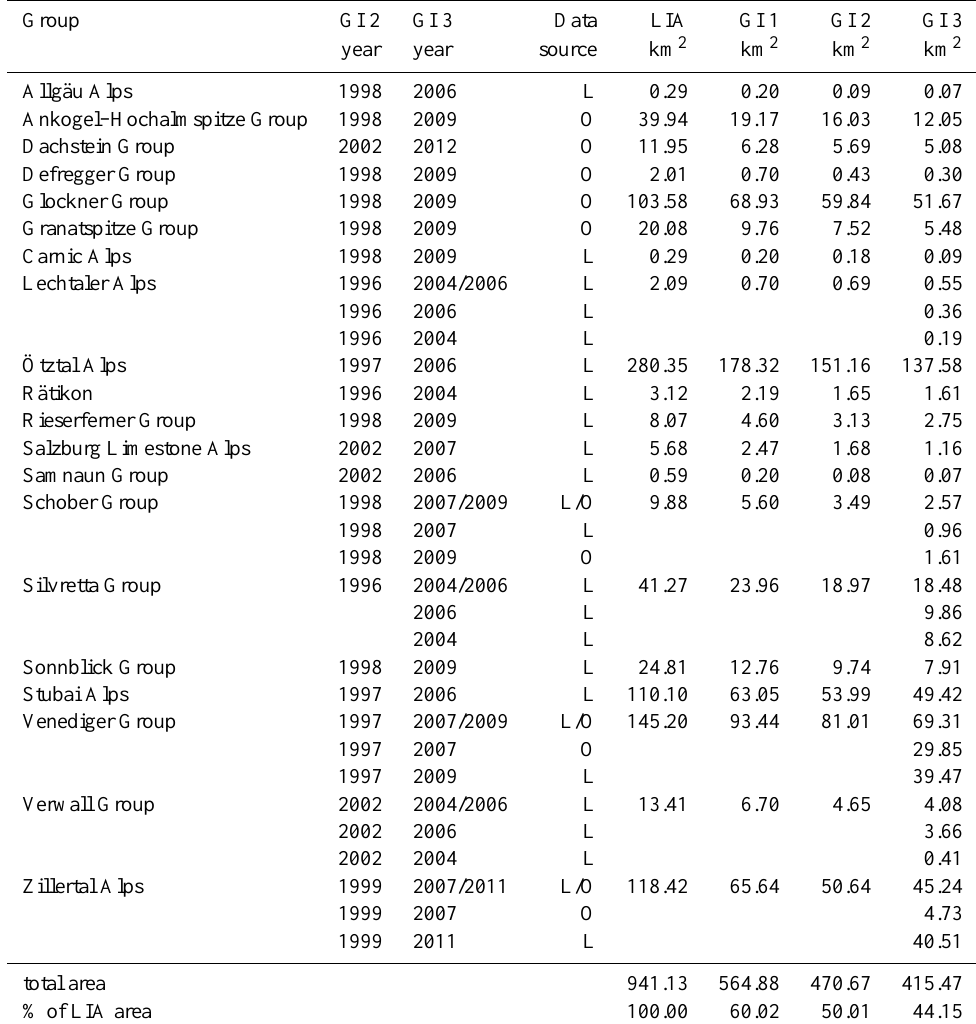
Table 2. Acquisition times of the glacier inventories with glacier areas for specific mountain ranges shown in Fig. 1; L means lidar ALS data and O means